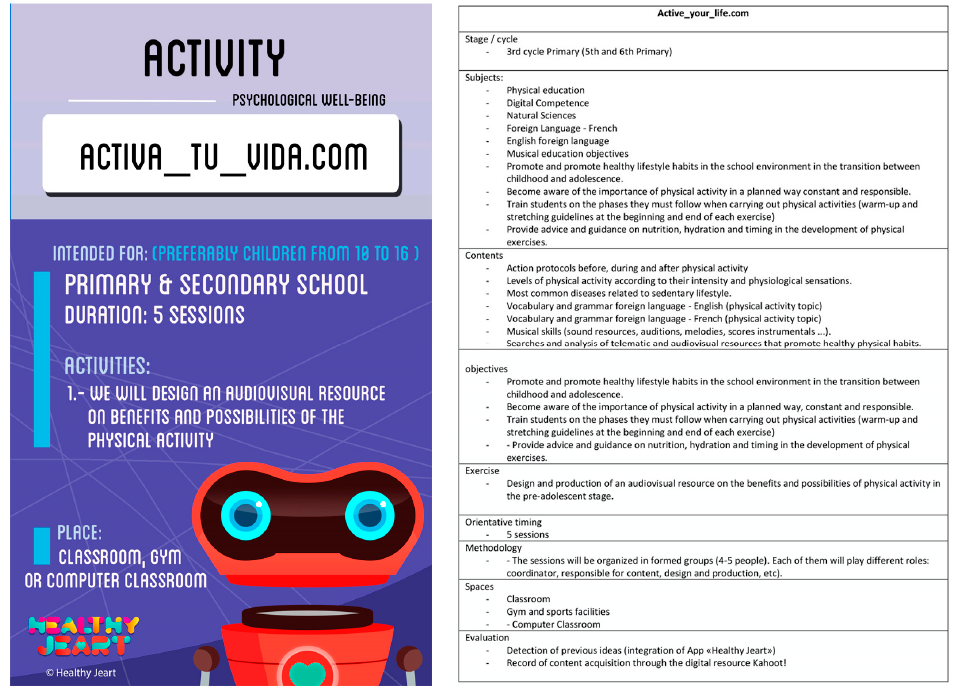
Figure 2. Image from the website. Frontal page of the didactic activities of physical